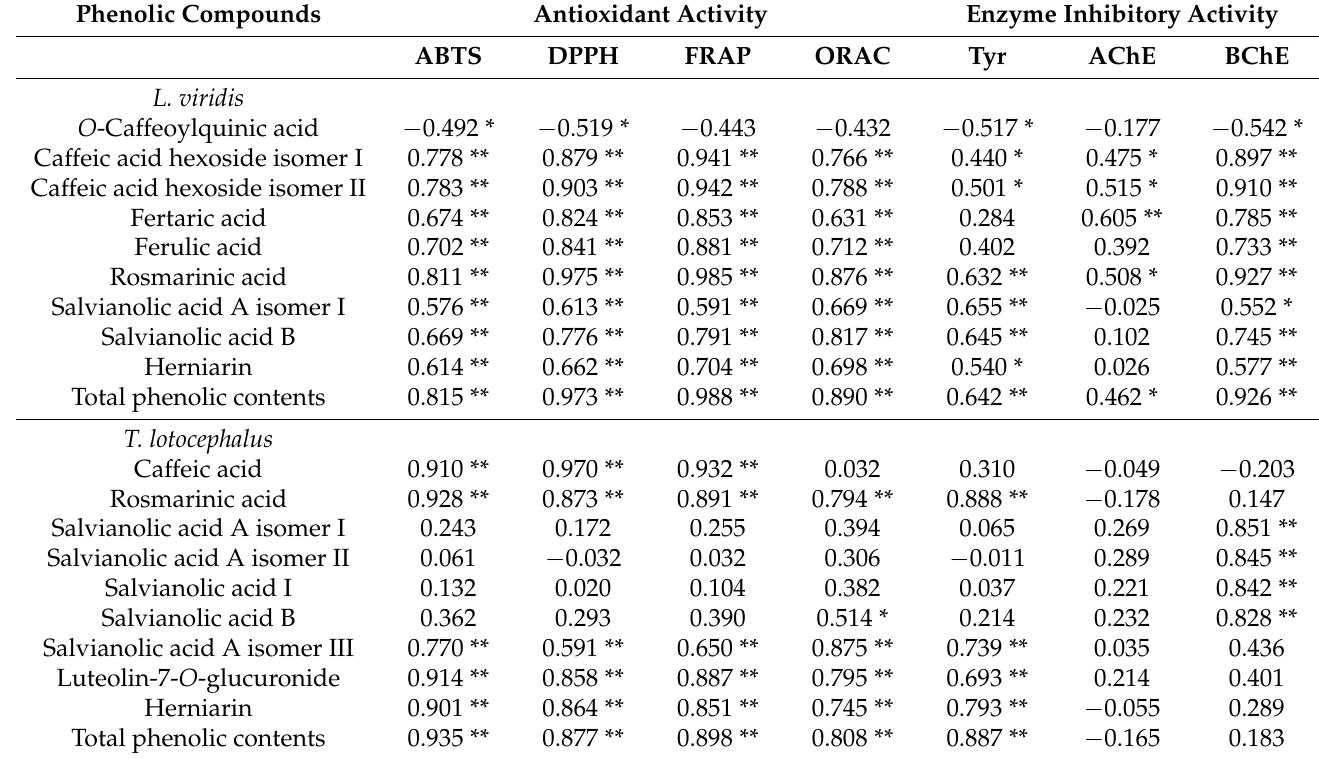
Table 3. Pearson’s correlation coefficients between antioxidant activity measured by the different assays (DPPH, FRAP, ABTS, and ORAC), enzyme inhibitory activities (AChE, BChE, and Tyr), total and individual phenolic compounds determined by